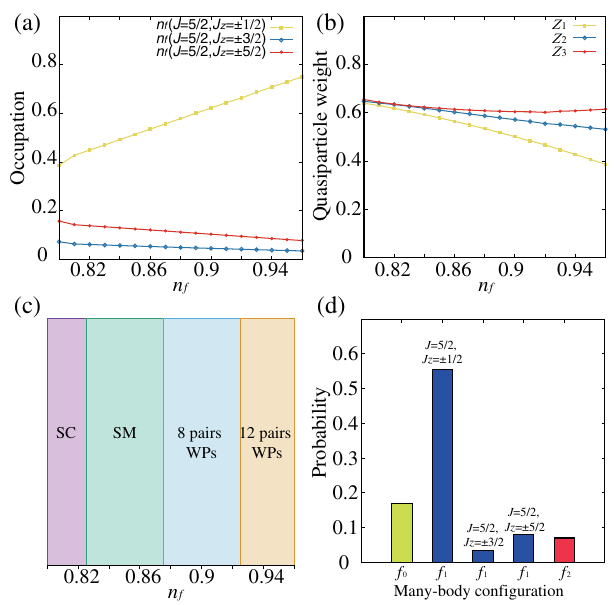
FIG. 6. (a) The occupation of f orbitals with J ¼ 5 = 2 , J ¼ (cid:2) 1 = 2 , (cid:2) 3 = 2 , (cid:2) 5 = 2 characters; (b) the quasiparticle weights z for the 4 f orbitals with J ¼ 5 = 2 ; (c) phase diagram of CeRu 4 Sn 6 , with a change of the total 4 f orbital occupation number. The violet and green regions are semiconductor (SC) and semimetal (SM) phases. The blue and yellow regions are WSM phases with 8 and 12 pairs of Weyl points, respectively. (d) The histogram of the atomic configurations for the case of n f ¼ 0 . 9